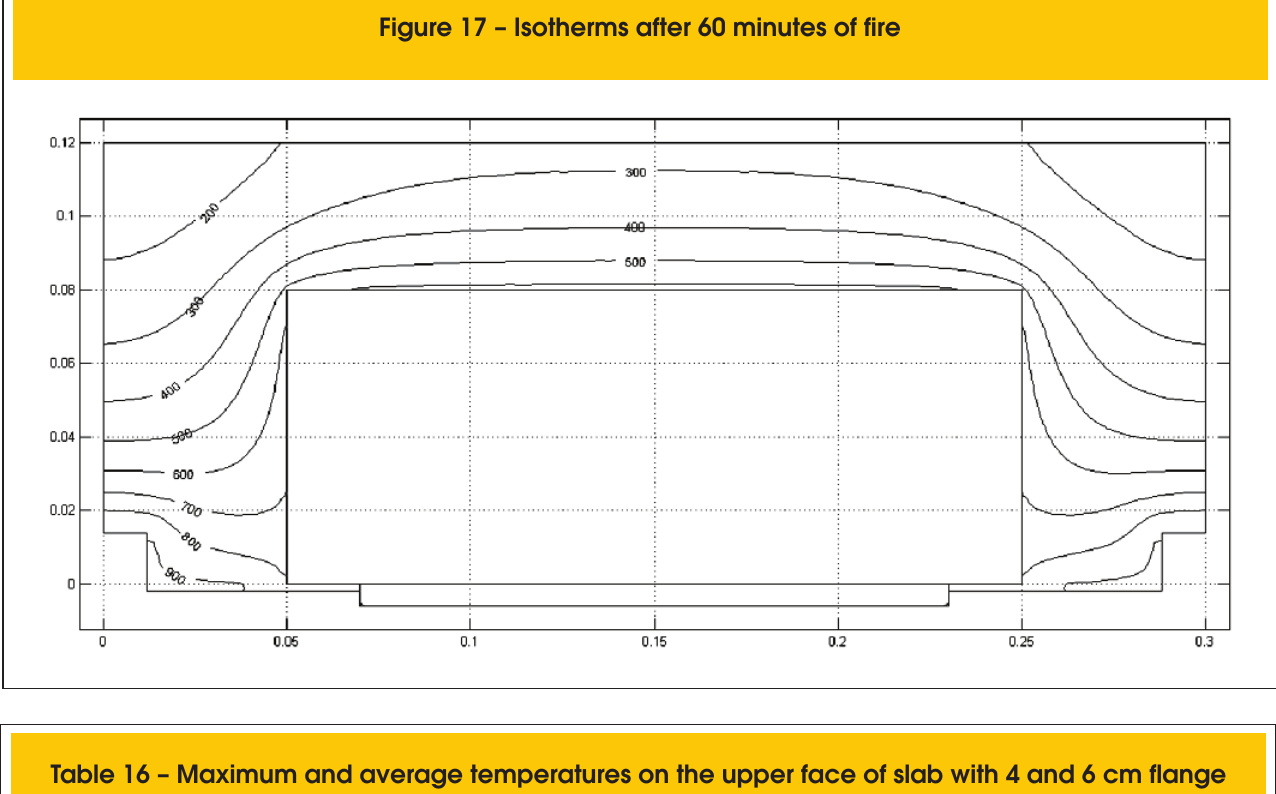
Table 16 – Maximum and average temperatures on the upper face of slab with 4 and 6 cm flange